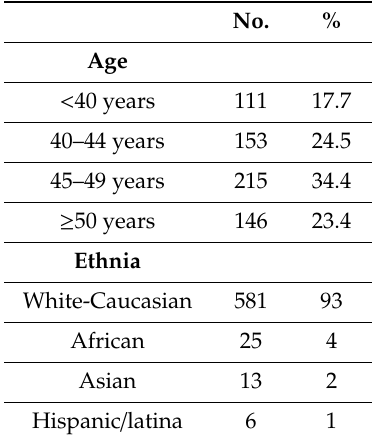
Table 1. Population’s demographic